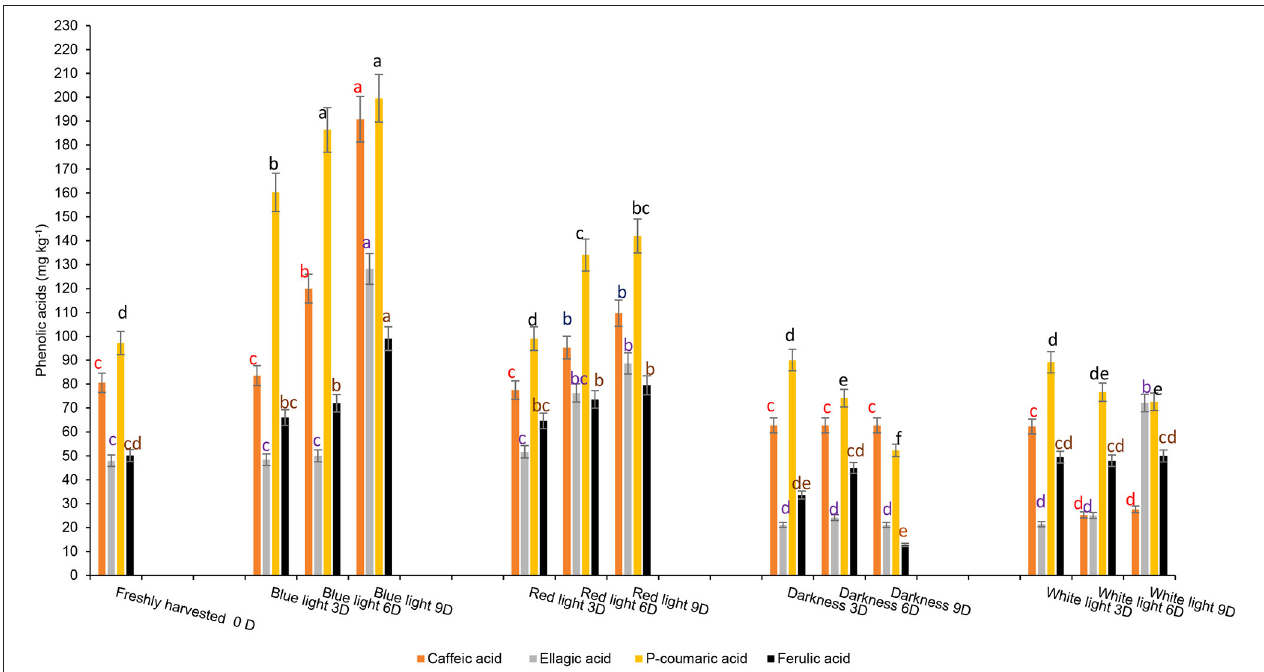
FIGURE 6 | Effect of blue and red LED light treatments on the changes in the concentration of major phenolic acids in coriander ( Coriandrum sativum ) leaves. Different letters in the same bar indicate significant differences at p < 0.05 for a specific phenolic acid.